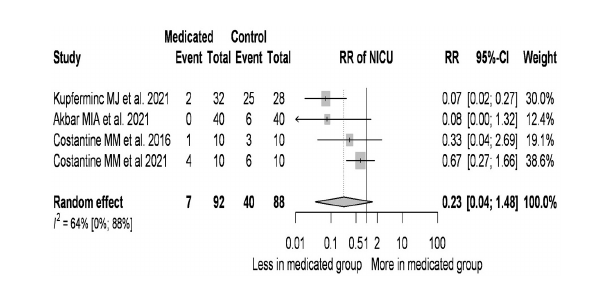
FIGURE6 Reduction in NICU admission with pravastatin treatment–forest